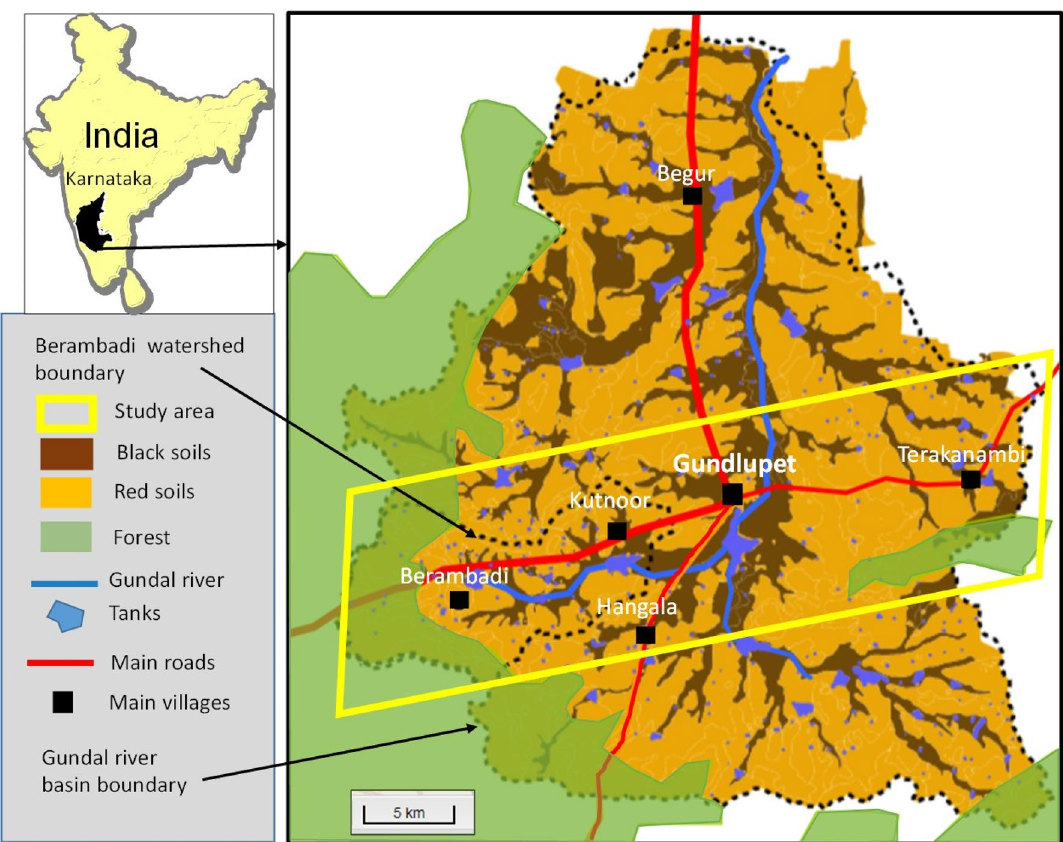
Figure 1. Location of the study area in Gundlupet Taluk, South Karnataka, India. The Gundal flows northward, and the river basin boundary closely follows that of the Taluk. The western part of the study area comprises the Berambadi experimental watershed (84 km 2 ). We generated the map with 4georchestra version 2.17 (https:// geosas. fr/ porta ils/? porta il=